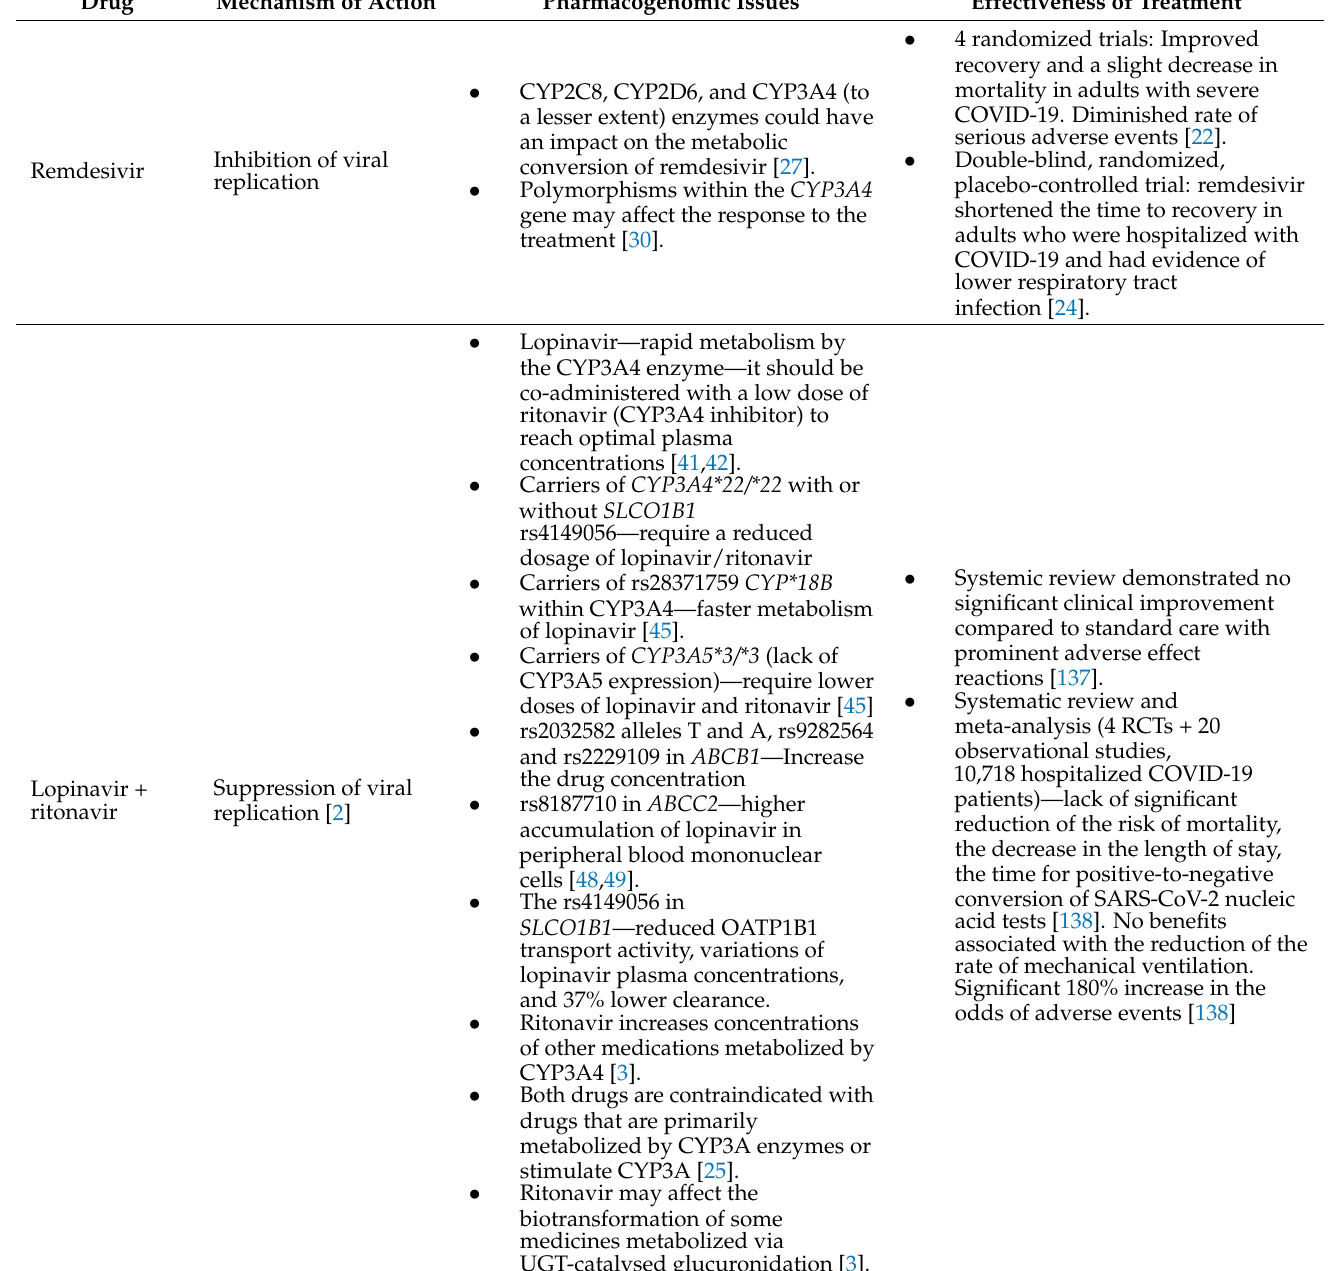
Table 1. Impact of pharmacogenetic on the treatment efficacy and adverse effects.